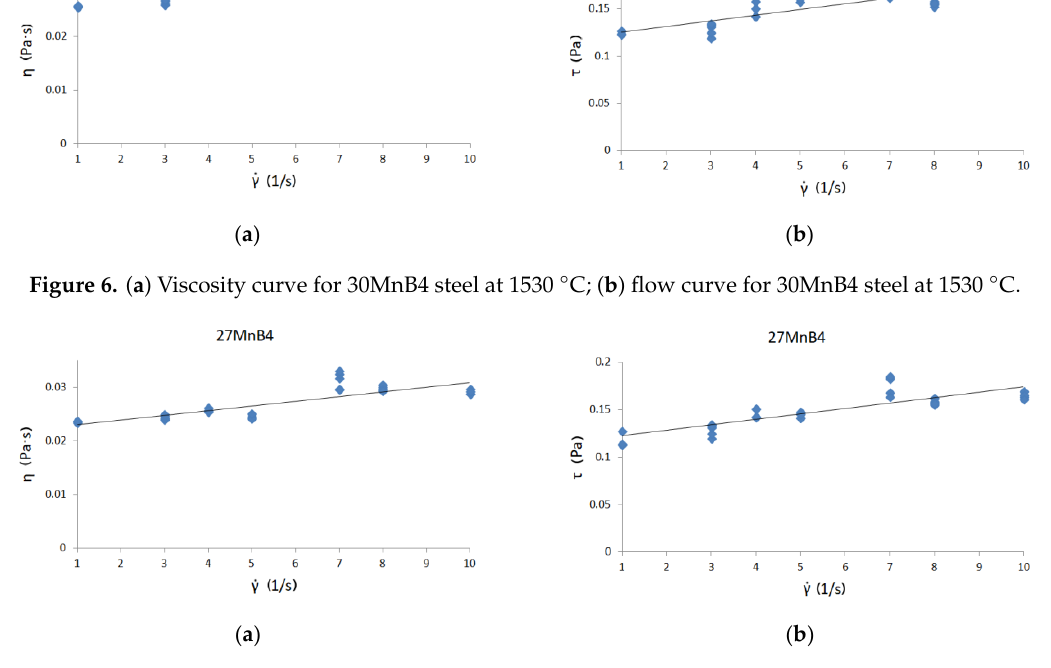
Figure 8. ( a ) Viscosity curve for C45 steel at 1530 °C; ( b ) flow curve for C45 steel at 1530 °C. Viscosity curves are the dependence between γ̇ —shear rate and η — dynamic viscosity coefficient. Flow curves are the dependence between τ—shear stress and η — dynamic viscosity coefficient [9]. Black lines on the graphs indicate the trend. In addition, during measurements, it was observed that superheated steels exhibit the same dynamic viscosity coefficient as steels at liquidus temperature (for analyzed steel grades), so it has been assumed that steel at a ladle temperature of 1560 °C will have the same dynamic viscosity coefficient as at 30 °C lower, but still above liquidus temperature of the given alloy. The course of the curves is similar to the curve of a perfectly viscous fluid. The lowest values of the dynamic viscosity coefficient were obtained for C45 steel—about 0.0255 Pas—while the highest value of the dynamic viscosity coefficient was for 30MnB4 grade—0.0298 Pas. A value of 0.0271 Pas for the dynamic viscosity coefficient was obtained for grade 27MnB4. Figures 6b, 7b and 8b present flow curve graphs—i.e., the relationship between shear rate and shear stress. This presentation of results is typical for rheological analysis of fluid behavior. In order to verify the influence of the chemical composition on the values of dynamic viscosity coefficient, it is necessary to conduct detailed tests in two-component systems containing iron with an alloying additive, so that it is possible to determine the influence of a given alloying component on the value of dynamic viscosity coefficient. With complex chemical composition, it is difficult to make unequivocal conclusions about the impact of selected elements on the value of the dynamic viscosity coefficient of iron solutions. At this stage, one can only suspect that the increase in carbon content may affect the reduction in the dynamic viscosity coefficient of the iron solution. However, the increase in manganese content seems to cause a slight increase in the value of the dynamic viscosity coefficient of such a solution. 2.4. Rheological Models In the next part of the work, the obtained data were verified using rheological models, namely the Newton model [9] and the author’s empirical MKH1 model [23,27], using the chemical